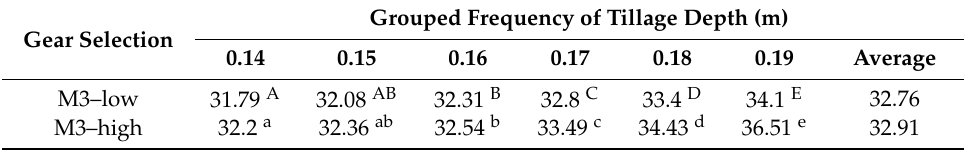
Table 6. Comparison of mean draft force (kN) at di ff erent levels of grouped tillage